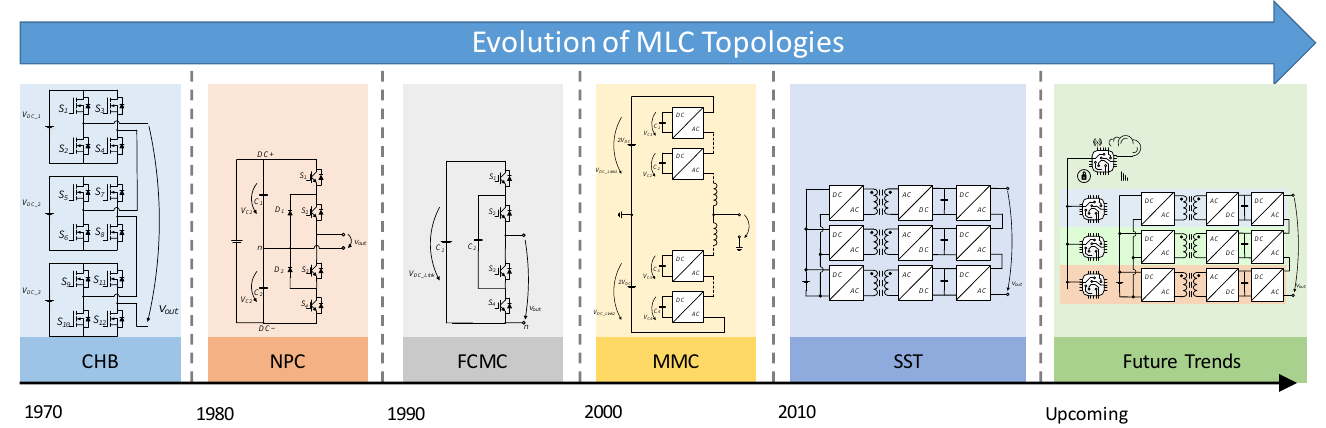
Figure 2. Evolution and emergence of new MLC topologies.